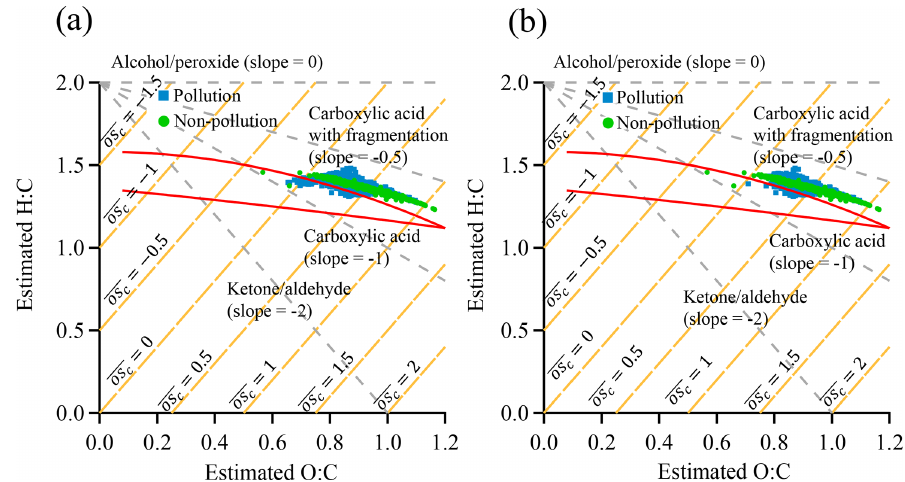
Figure 11. Plot of estimated H / C ratio as a function of estimated O / C ratio for SOA in the van Krevelen diagram: (a) non-pollution vs. pollution EPs; (b) non-pollution vs. pollution EPs with an overlapped NO x concentration range during the two periods. The area enclosed by the two red boundary lines was defined for ambient OOA components in Ng et al.